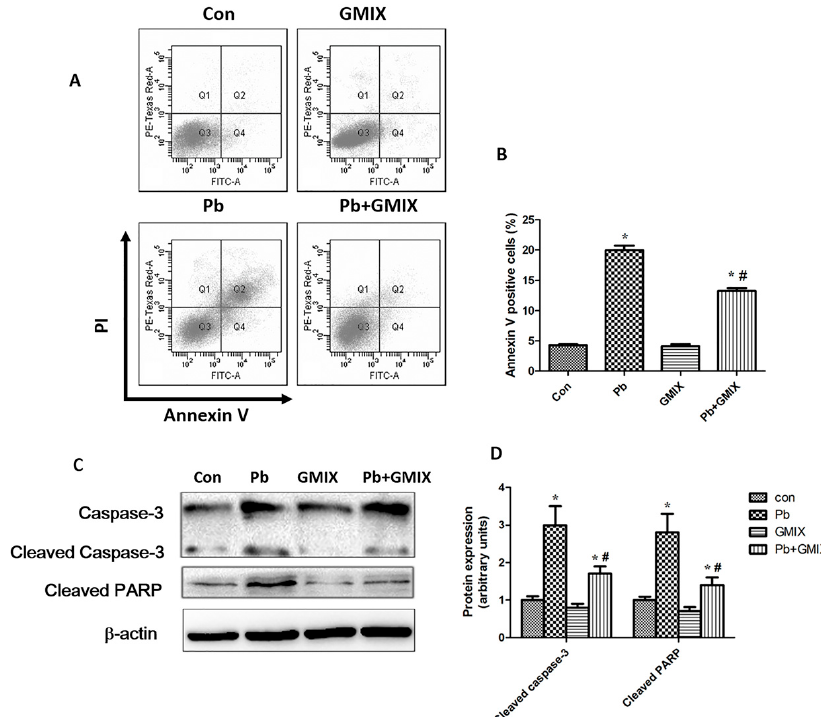
Figure 4. Gangliosides mitigate Pb-induced apoptosis by mediating apoptosis-related proteins in HT22 cells. ( A ) Flow cytometry analysis in response to Con, Pb, GMIX and Pb+GMIX group, and representative dot-plots illustrating apoptotic status were shown; ( B ) Histograms from cell apoptosis were shown for analyzed cells; ( C ) Protein expression of caspase-3 and PARP; ( D ) The values from the densitometry are normalized to the level of β -actin protein and expressed as mean-fold increase. The data are expressed as means ˘ SD of three independent experiments. * p < 0.05 vs. control group; # p < 0.05, vs. Pb